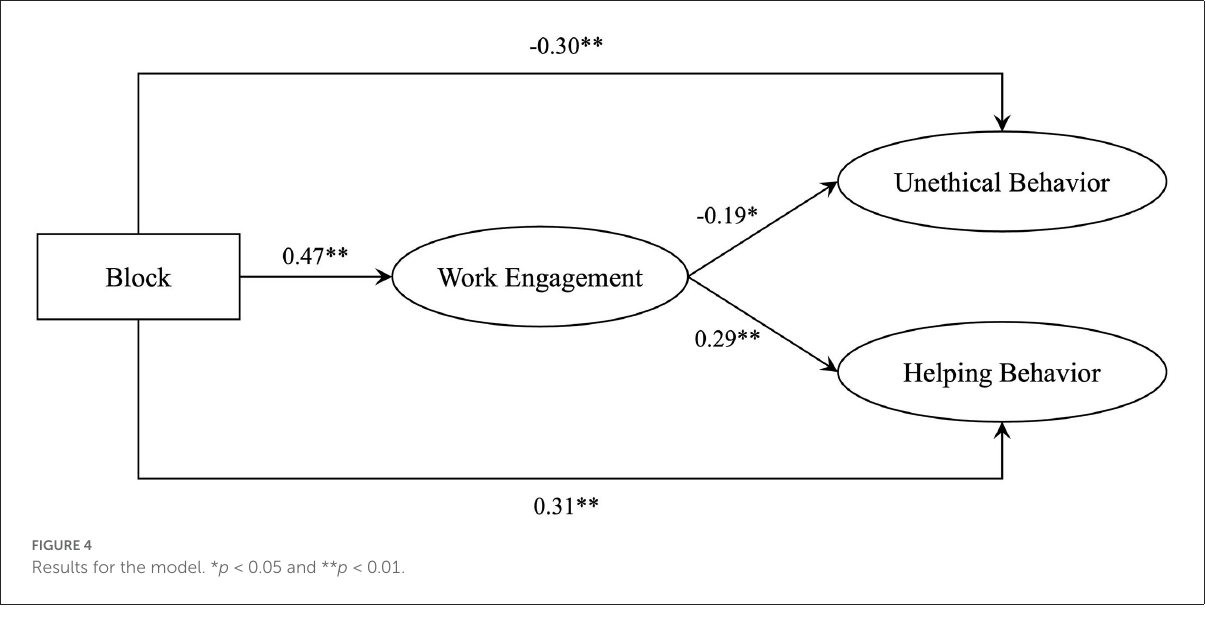
TABLE 4 Results of bootstrapping